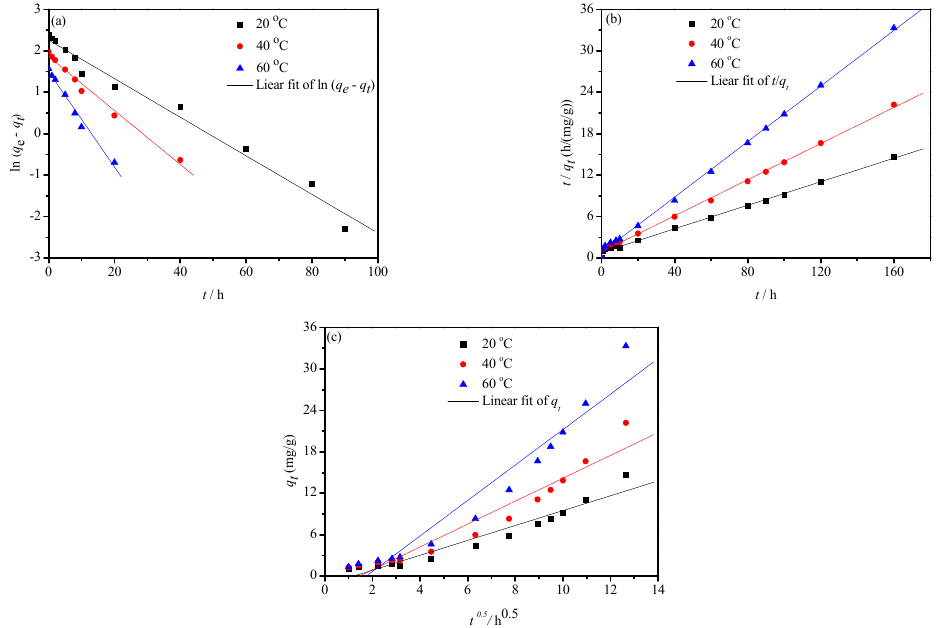
Figure 7. HCHO adsorption kinetics data on CGC at 20, 40, and 60 °C and their linear regressions by: ( a ) pseudo-first-order model; ( b ) pseudo-second-order model; and, ( c ) intra-particle diffusion model. Table 4. Kinetic parameters for adsorption of HCHO on CGC.